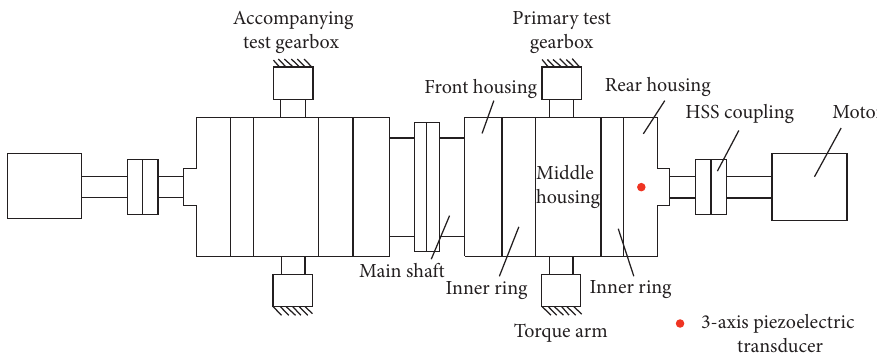
Figure 14: Back-to-back vibration test bench assembly